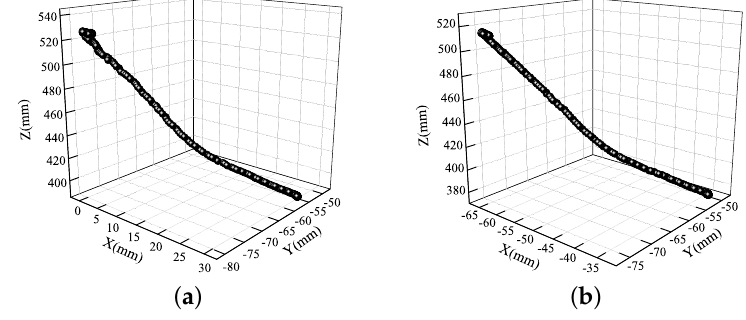
Figure 14. 3D eye trajectories during car braking: ( a ) left eye; ( b ) right